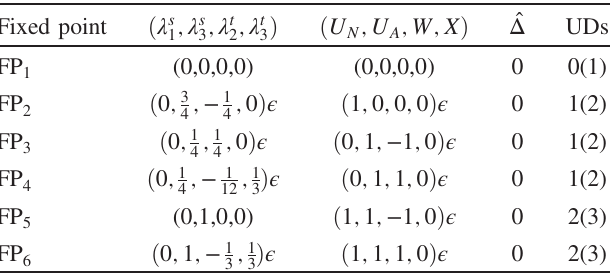
TABLE III. Location of the fixed points obtained from the RG flow equations as we set n → ∞ in Eqs. (30) and (31), in the perturbative quadratic-order corrections to the four-fermion cou- pling constants. The resulting RG flows are displayed in Eq. (32). The noninteracting semimetal is labeled FP 1 and has only one unstable direction; it controls the direct quantum phase transition between the Dirac semimetal and band insulator for sufficiently weak interactions. By contrast, each of FP 2 has two unstable ; 3 ; 4 has three unstable directions, and these directions and FP 5 ; 6 correspond to interacting multicritical points. The penultimate ˆ Δ rightmost column shows the value of the band parameter at each such fixed point. If we follow the RG trajectory along which the ˆ Δ renormalized band parameter is kept fixed, i.e., ¼ 0 , then FP 2 ; 3 ; 4 represent interacting quantum critical points with only one unstable direction and FP 5 become bicritical points with two unstable ; 6 directions. A schematic plot of these fixed points is shown in Fig. 9. The last column shows the number of unstable directions (UDs) at a ˆ Δ given fixed point in the ¼ 0 hyperplane, as well as in the five- dimensional coupling constant space (shown in